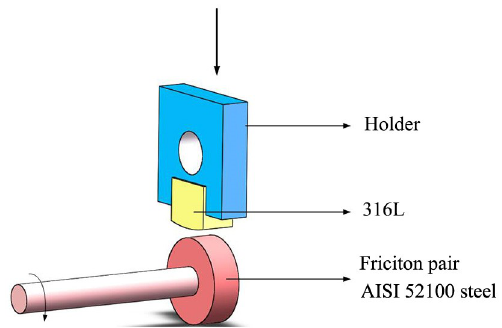
Figure 2. Schematic illustration of the ring-on-block wear test principles.